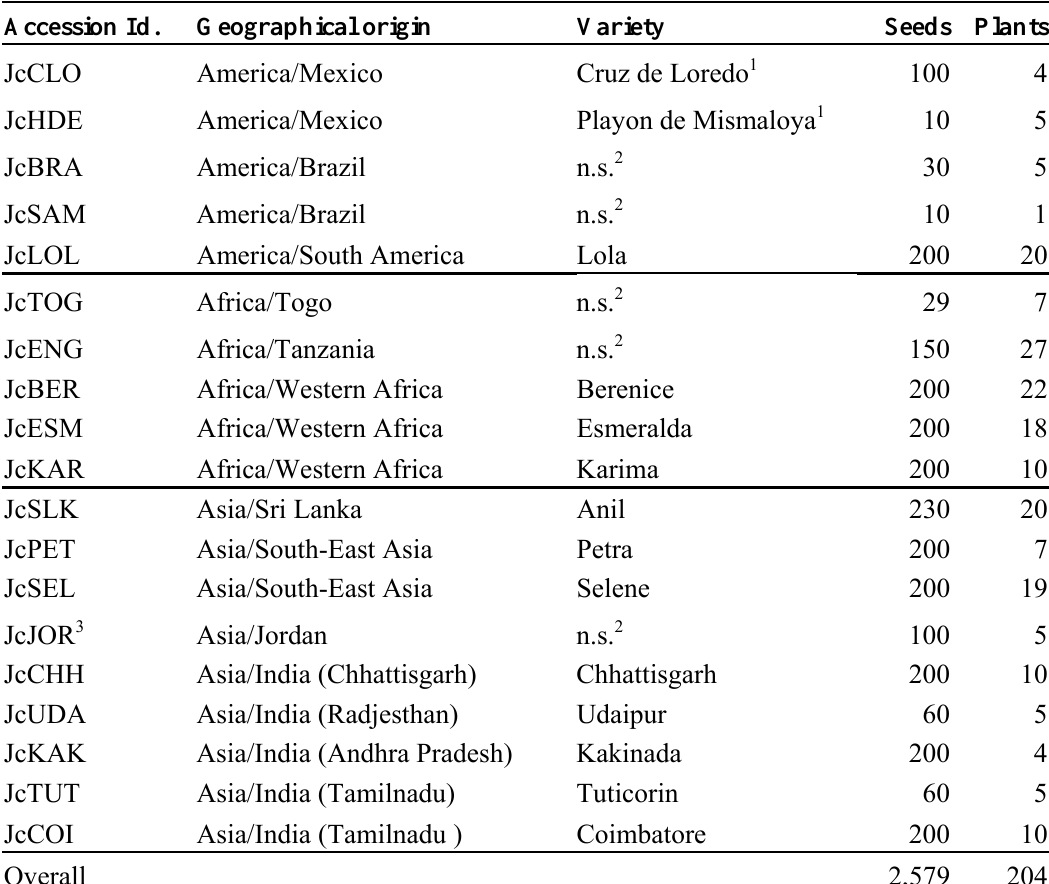
Table 1. The main information on J. curcas germplasm characterized by means of flow cytometric and molecular marker